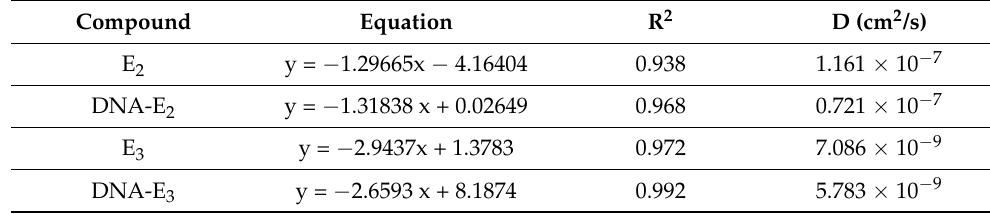
Table 5. Diffusion coefficient values of the free and DNA-bound forms of E 2 and E 3 .